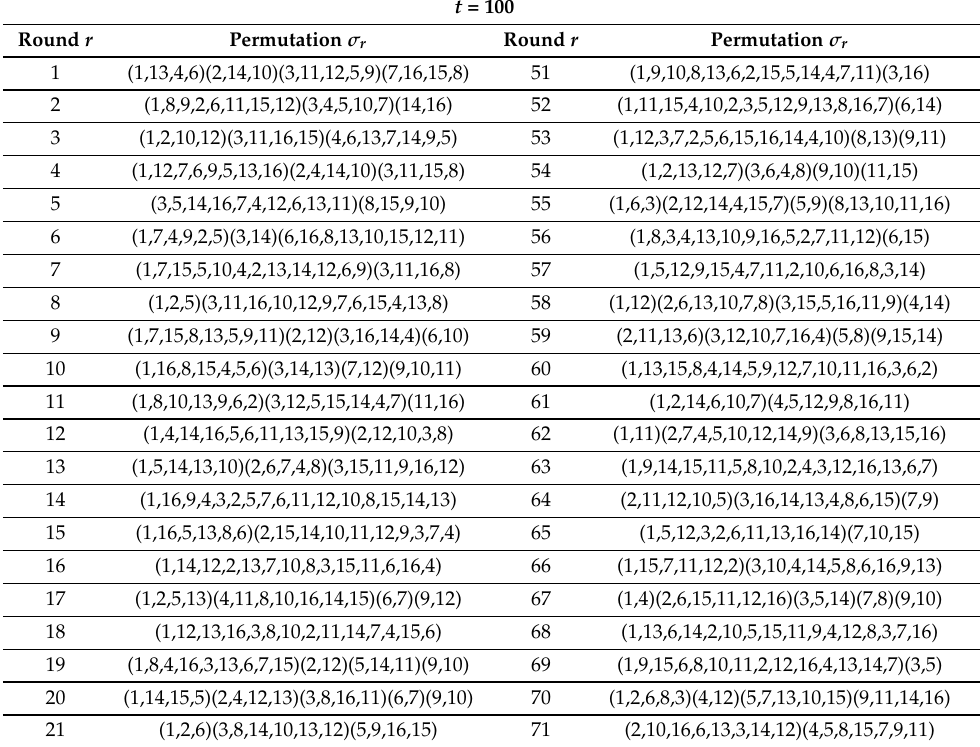
Table A3. For t up to 100 rounds, the list of random permutations σ r for 1 ≤ r ≤ 100. Each σ r is represented as the product of cycles operating on 16 patches of a 224 × 224